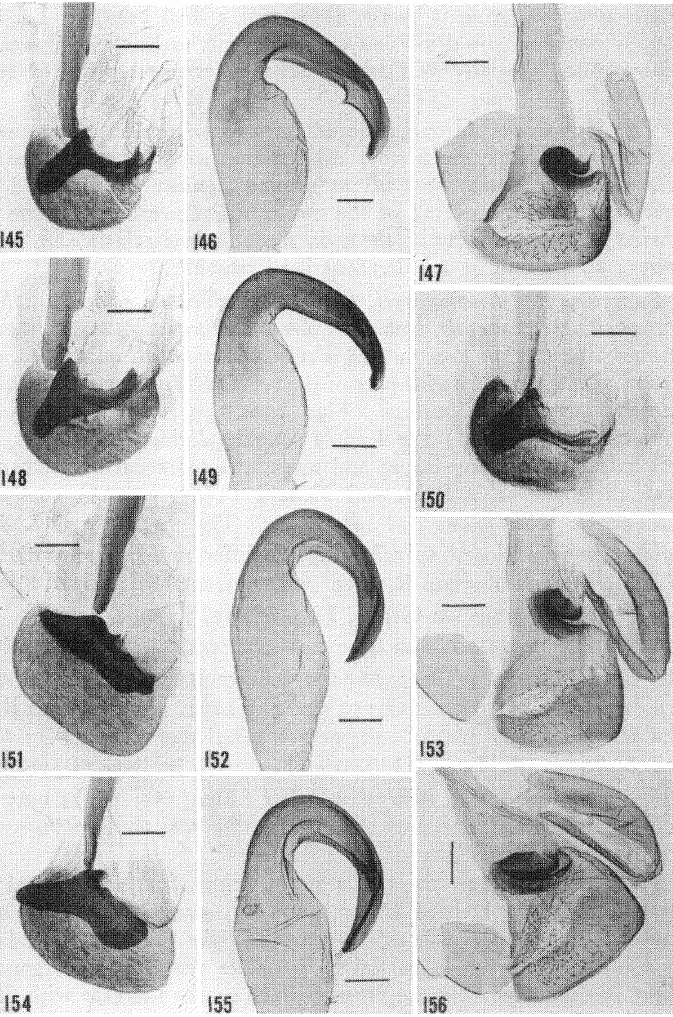
Figs. 145-156. Cockroach male genitalia. 145-150. Epilampra sabulosa. 145-147. (33 AMNH). La Moriniere, Haiti (det. Rehn). 148-149. (53 ANSP). Bourdon, Haiti (det. Rehn). 150. (149 ANSP). Porto Prince, Haiti. 151-156. Elilampra heeleri. 151-153. (32 AMNH). Adjuntas, Porto Rico (det. Rehn; from specimen shown in figure 8 in Rehn and Hebard, 1927). 154-156. (102 USNM). E1 Yunque, Porto Rico (det. Roth). (scale 0.2